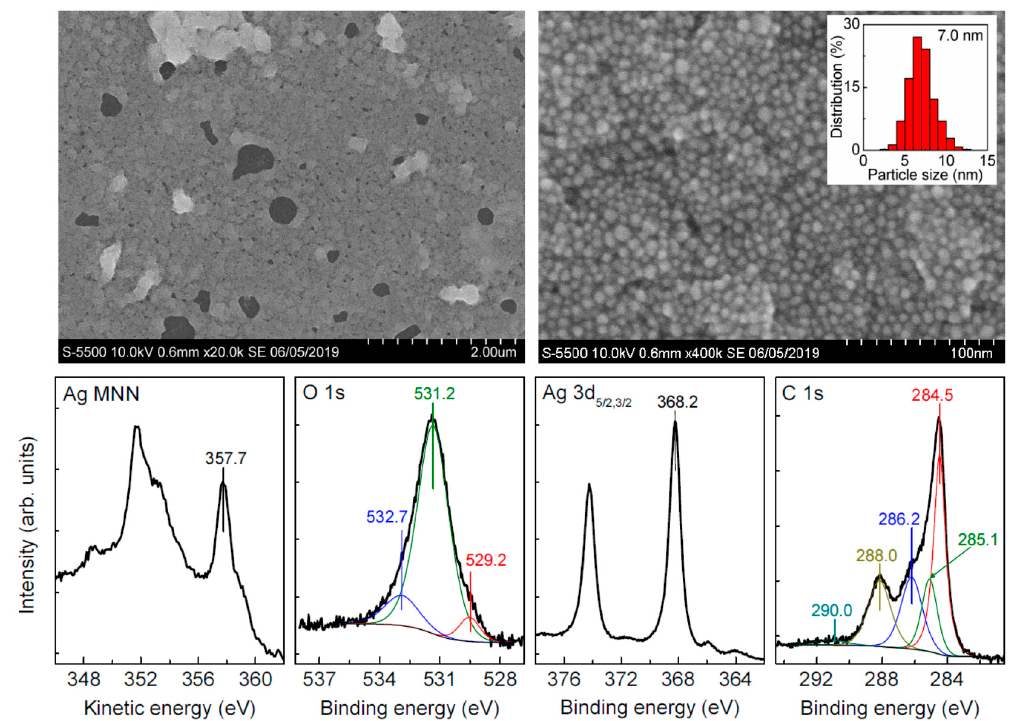
Figure 1. Typical scanning electron microscopy (SEM) images, particle size distribution, and X-ray photoelectron spectra (including X-ray-excited Ag M 45 NN Auger spectra) of unmodified Ag nanoparticle film deposited from Carey Lea hydrosol.